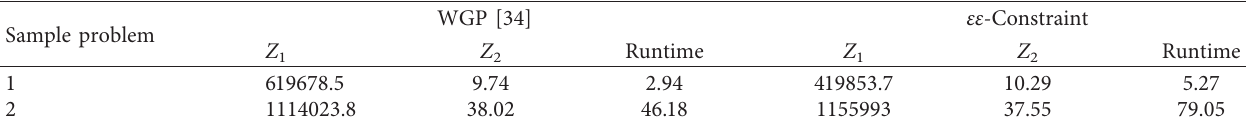
Table 15: Comparison of our proposed εε -constraint and WGP